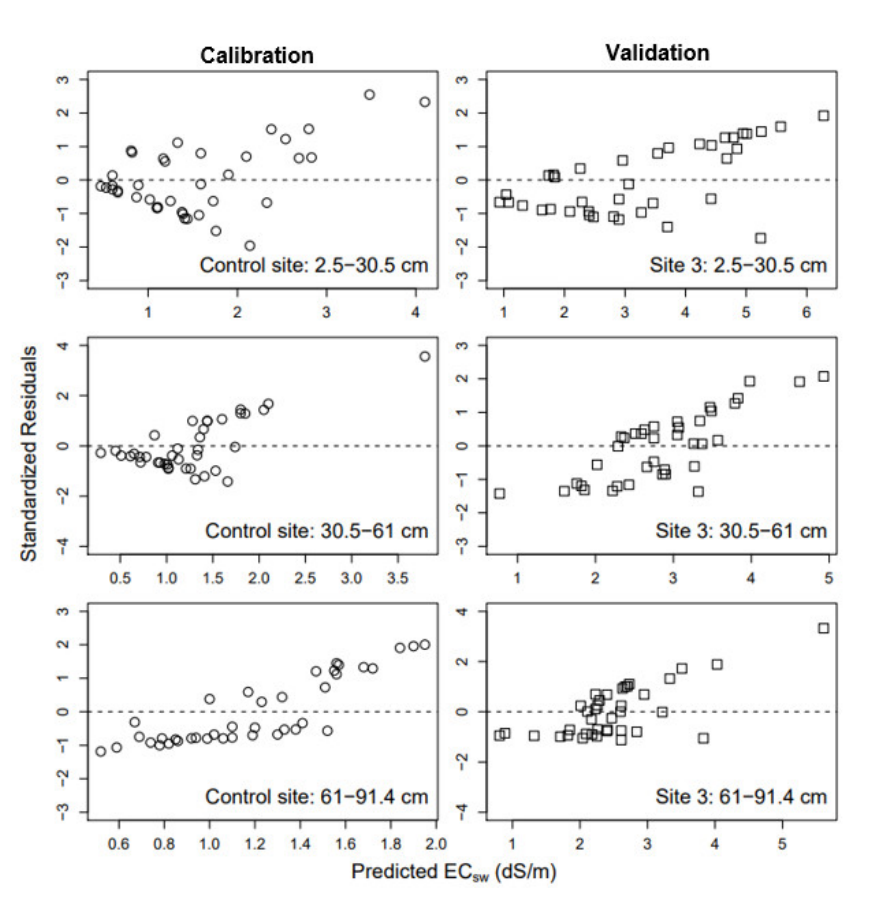
Figure 8. Predicted EC sw vs. standardized residuals at 2.5–30.5 cm, 30.5–61 cm, and 61–91.4 cm soil depths for control site (calibration) and site 3 (validation).